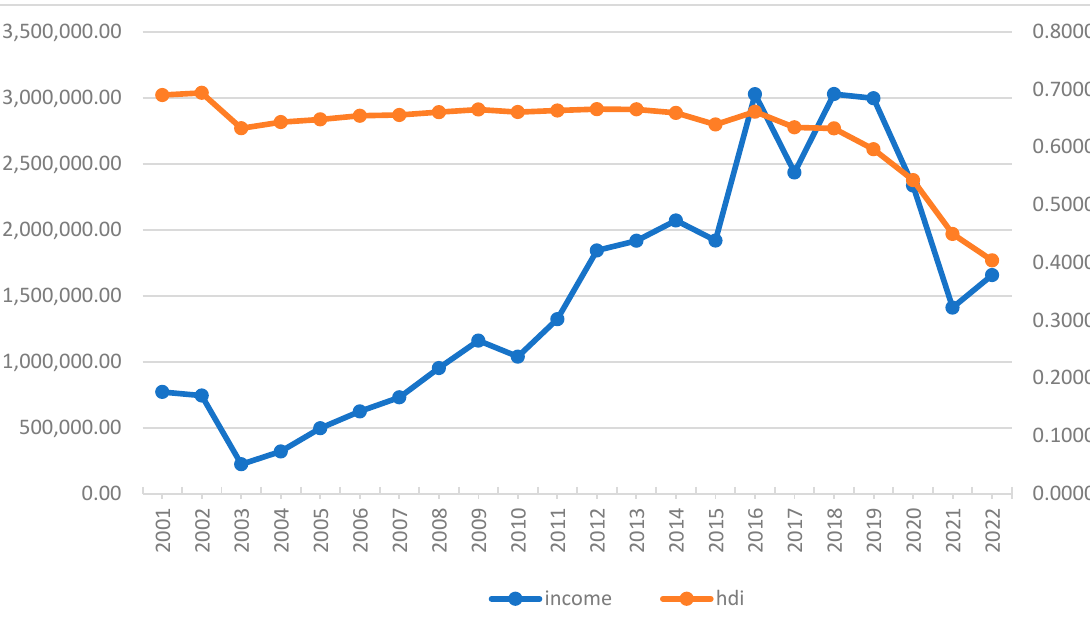
Figure 9. HDI and FRA Great Chaco 2001–2021. Source: DNCFP.